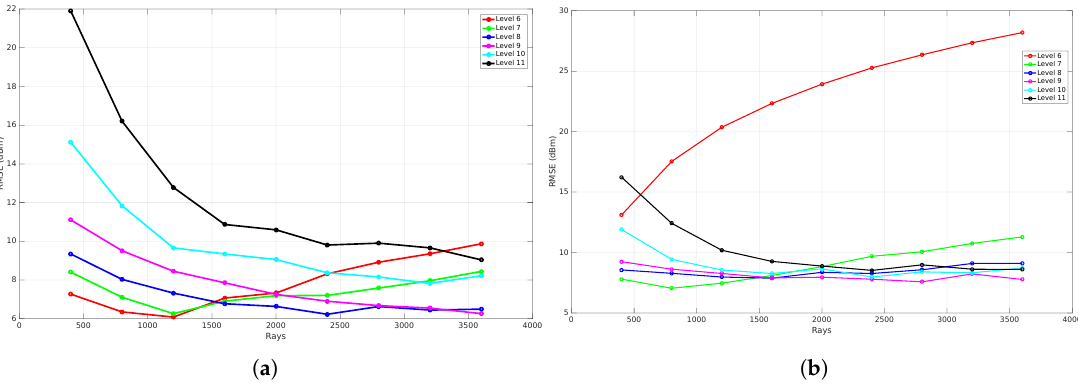
Figure 23. RMSE validation of the second office environment where no phase shifts are included. ( a ) zero neighbours are included; ( b ) eight neighbours are